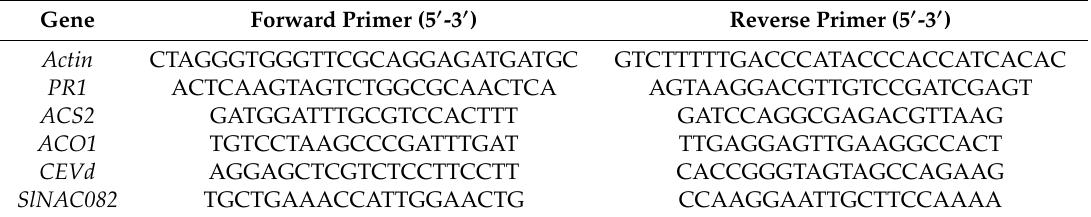
Table 1. Primer sequences used for real-time quantitative